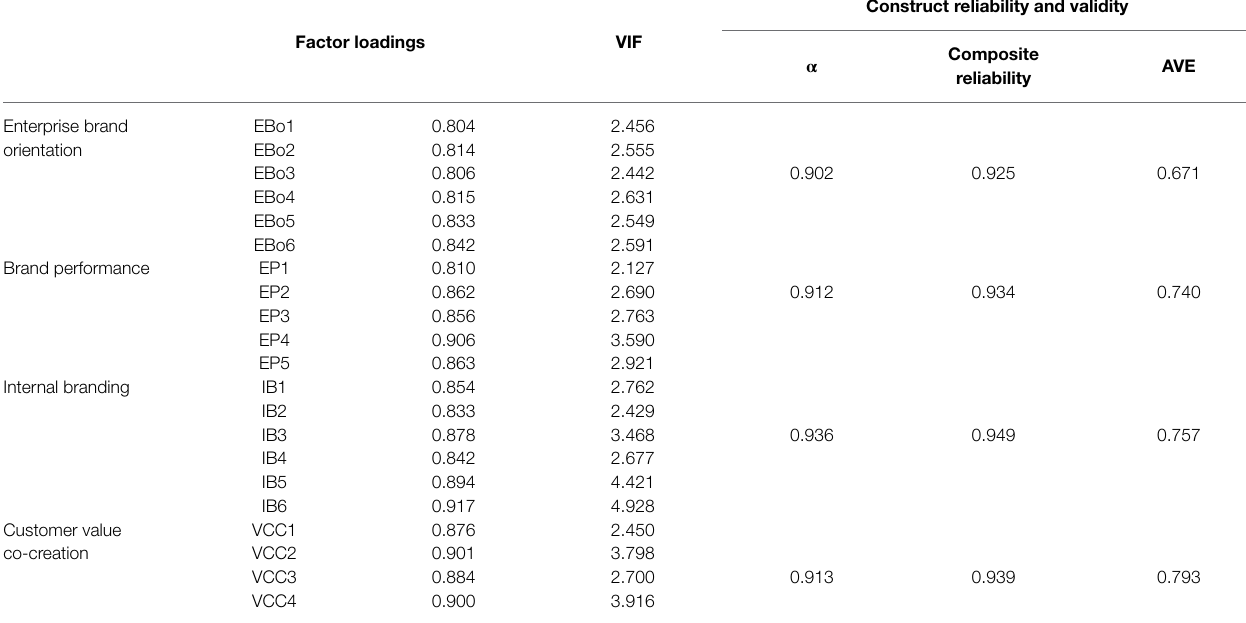
TABLE 2 | Model assessment (Direct model).